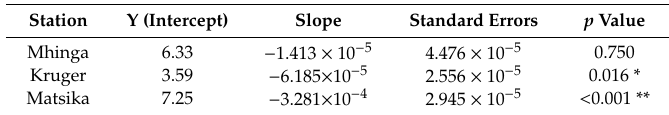
Table 2. Statistical results for flow trends analyses from the three selected stations flow. Trend significance level is indicated by * p < 0.05; ** p <